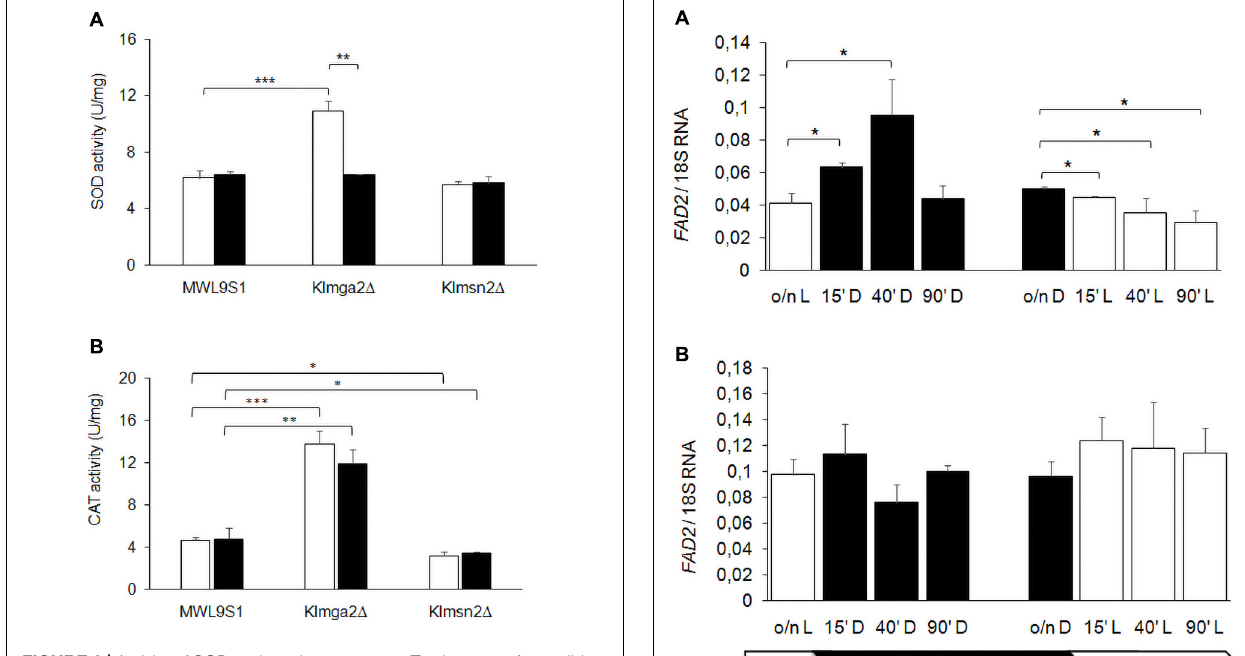
FIGURE 6 | Activity of SOD and catalase enzymes. Total extracts from wild type MWL9S1, Klmga2 (cid:49) and Klmsn2 (cid:49) strains, grown in light (white blocks) and dark (black blocks) conditions up to exponential phase, were assayed for catalase and superoxide dismutase activities. (A) shows SOD activities (U mg − 1 ): values are averages of three independent determinations, each measured by three technical repetitions, with standard deviations reported. (B) shows Kl Ctt1/ Kl Cta1 activities (U mg − 1 ): values are averages of two to four independent determinations, each measured by three technical